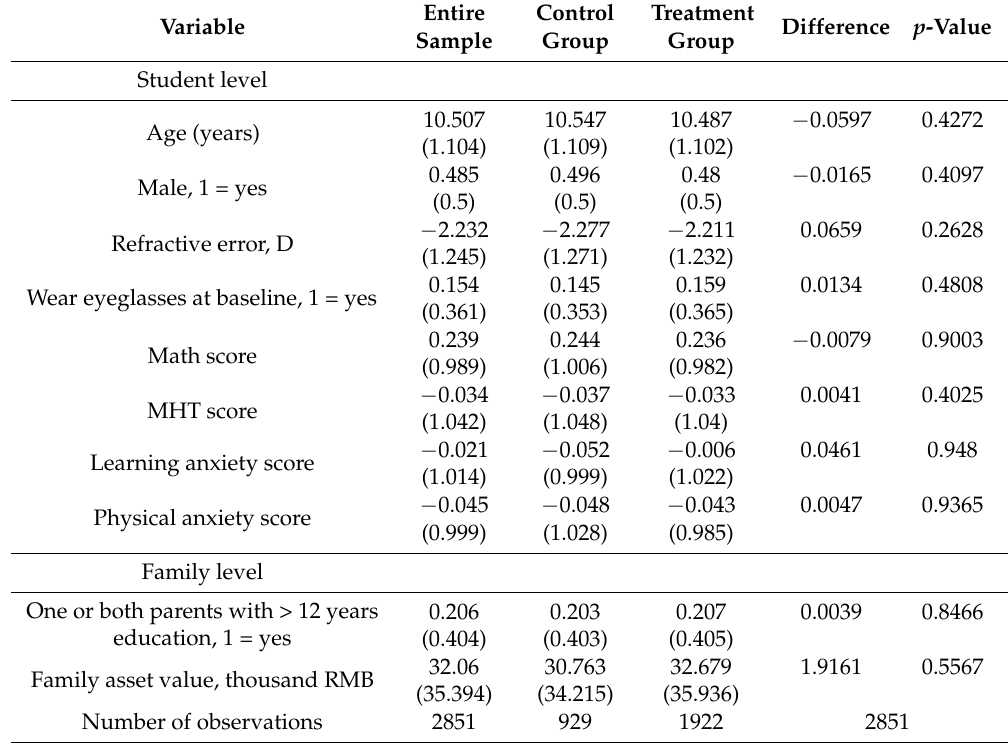
Table 1. Baseline Characteristics across Experimental